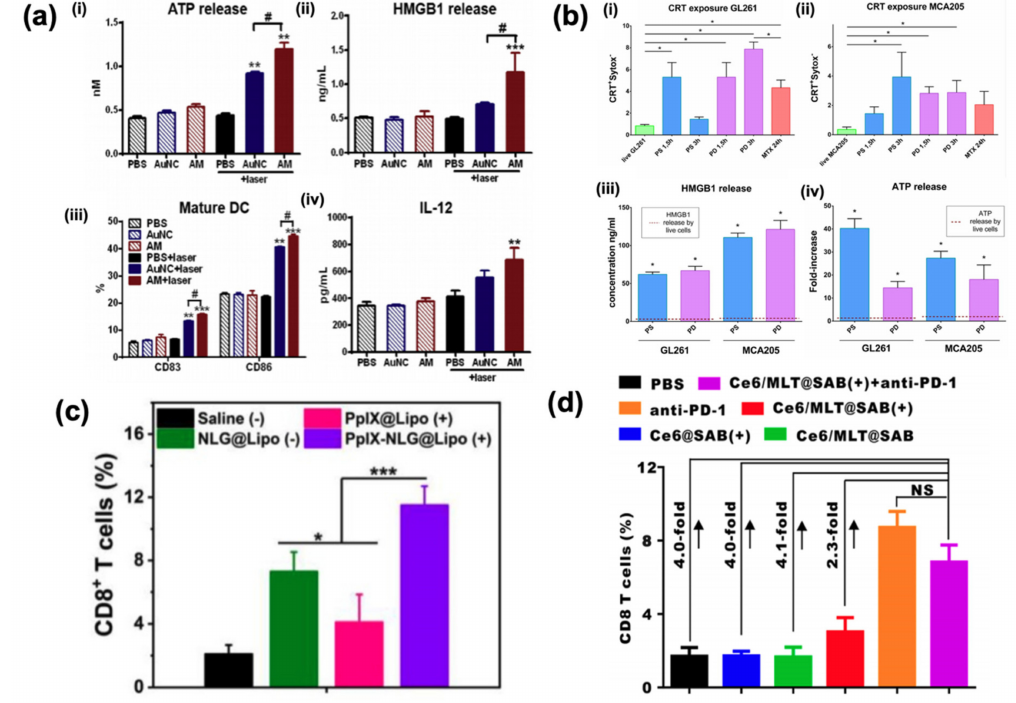
Figure 2. Immunogenicity of photodynamic treatments. ( a ) Evaluation of immunogenic factors in treating 4T1 cells with photodynamic therapy using gold nanocages coated in manganese dioxide,